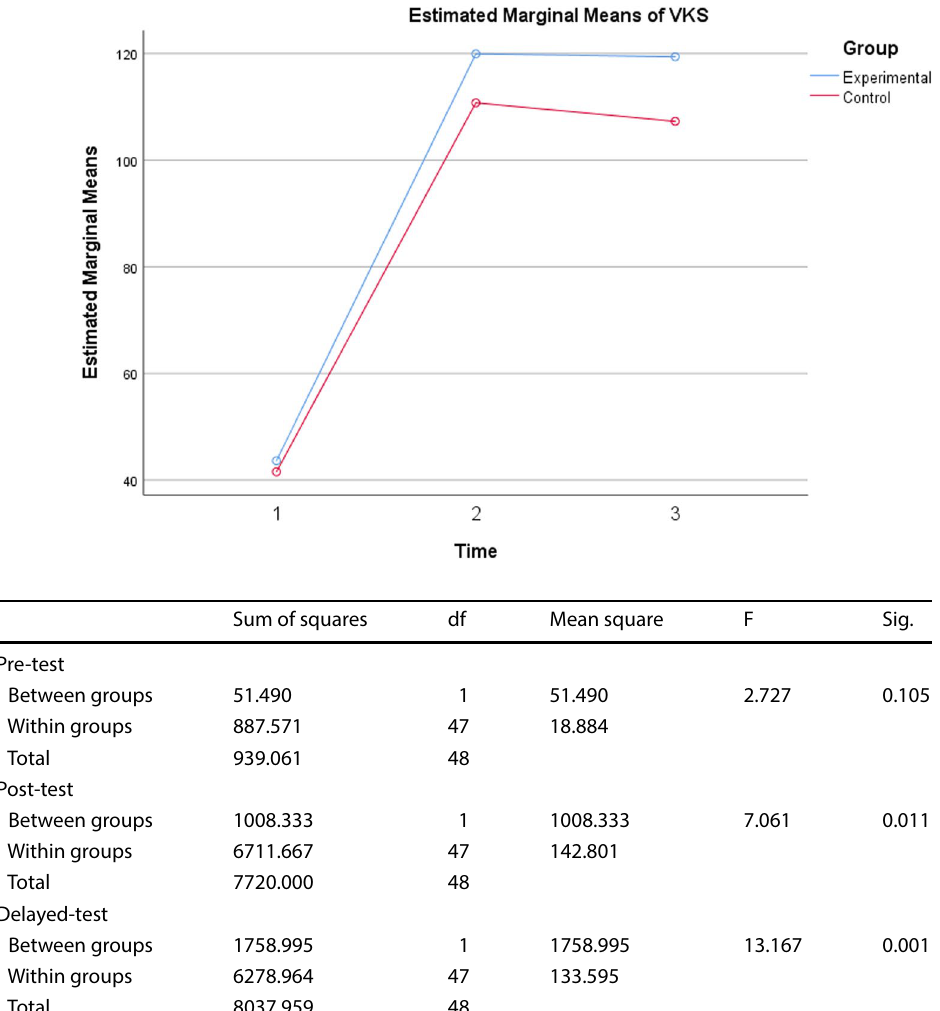
Fig. 2 Visual representation of the mean scores over time